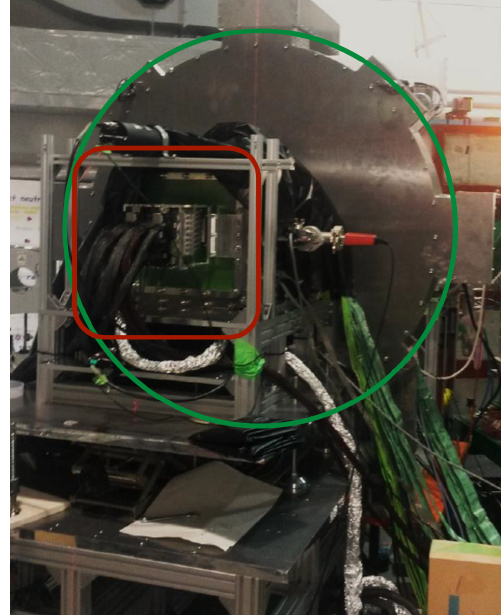
Figure 4. The test-beam prototype Phase-II detector, during the run at ELPH. The Straw Tube Tracker and Calorimeter pieces are indicated in green and red